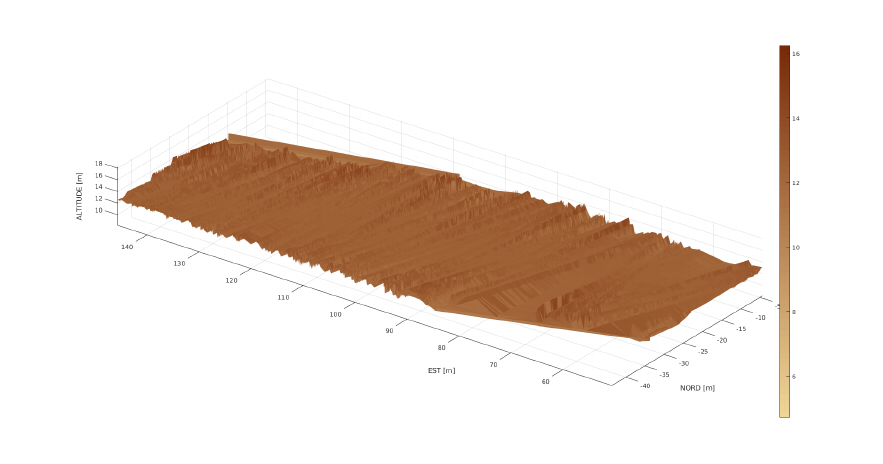
Figure 6. The underwater bathymetry map of the coastal area close to the Arno River